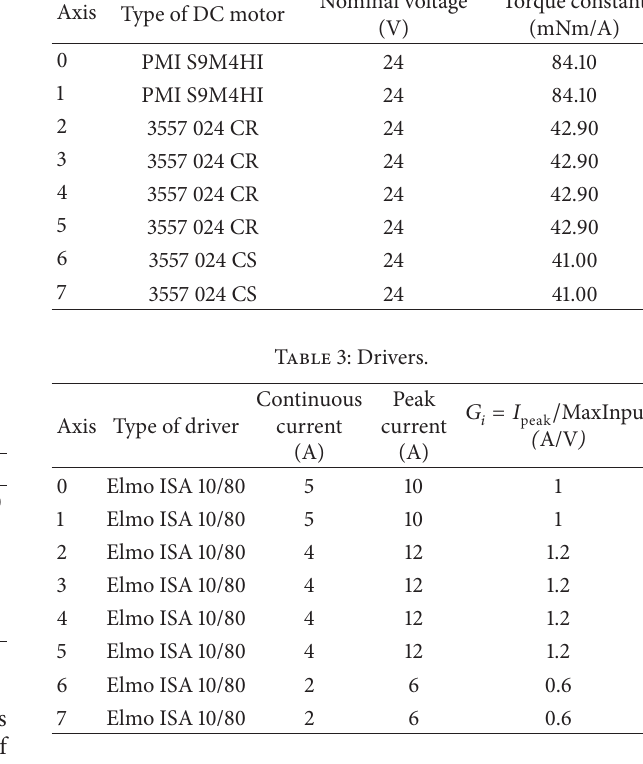
Table 4: Denavit-Hartenberg parameters.